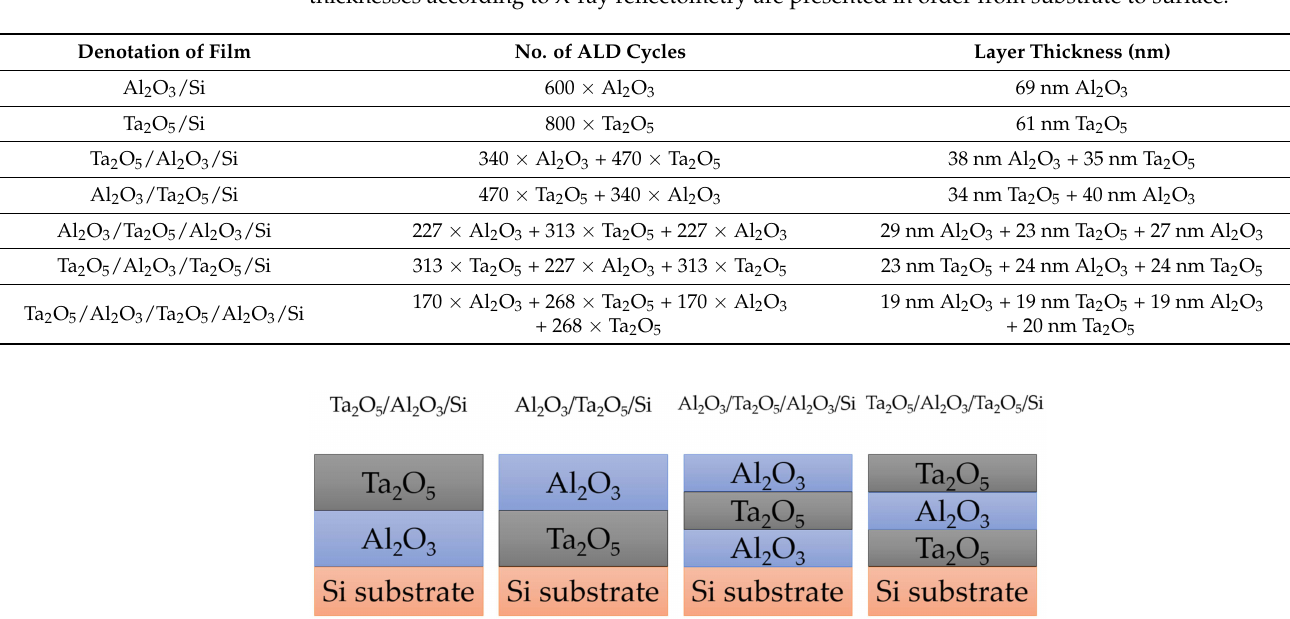
Table 1. Denotations of films with the number of atomic layer deposition cycles with Al 2 O 3 repre- senting the Al(CH 3 ) 3 and water cycle and Ta 2 O 5 representing the Ta(OC 2 H 5 ) 5 and water cycle. Layer thicknesses according to X-ray reflectometry are presented in order from substrate to surface.